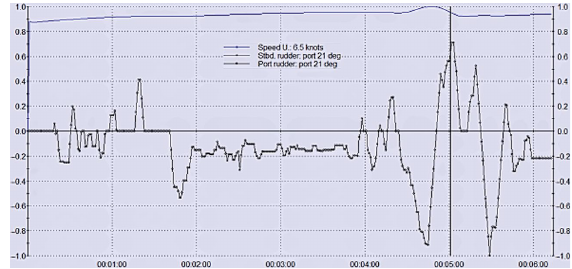
Fig. 10. Hydrodynamic influence between the PANAMAX tanker and a ferry expressed as rudder rotation in the narrow channel in opposite directions (vertical line in the figure corresponds to the ship position indicated in Fig. 9)